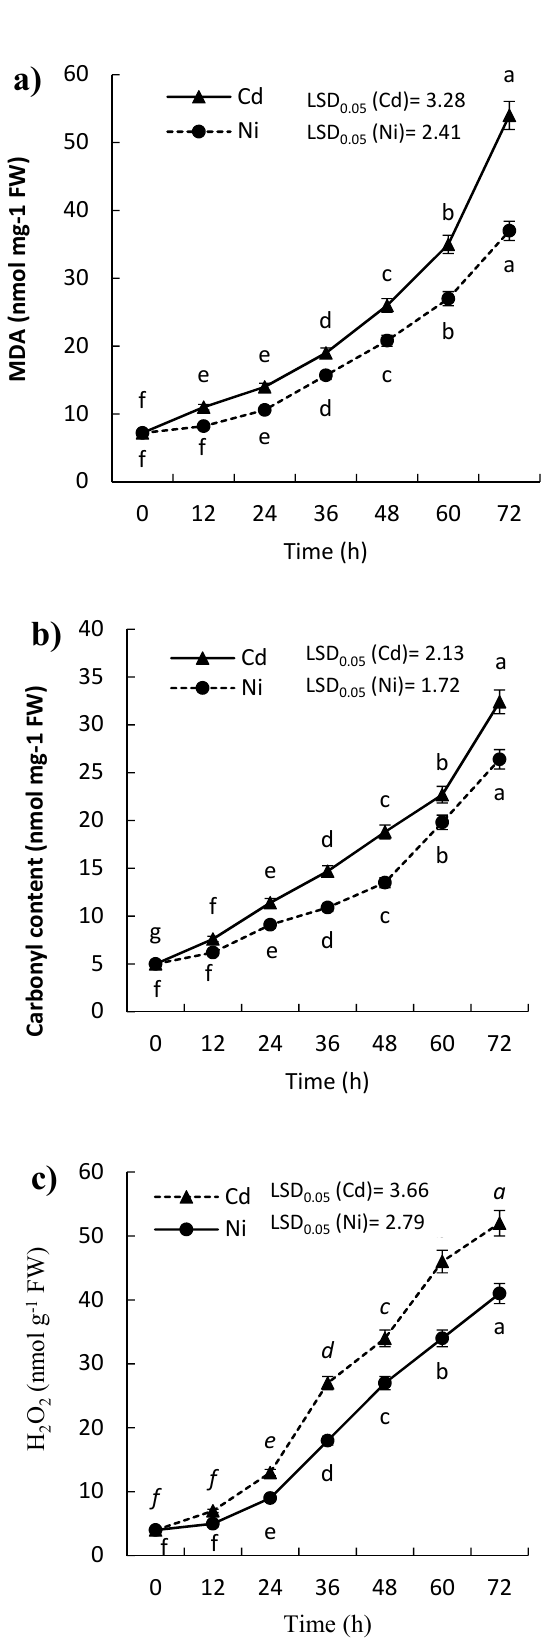
Figure 1. Effect of Cd and Ni on ( a ) malondialdehyde (MDA), ( b ) protein carbonylation, and ( c ) H 2 O 2 content of P. sativum leaves with time (0–72 h). Different letters per each line mean a significant difference ( p ≤ 0.05 ). Values are average of means ( n = 6 ), and bars represent the standard error. LSD 0.05 is the least significant difference at the probability level of 0.05.